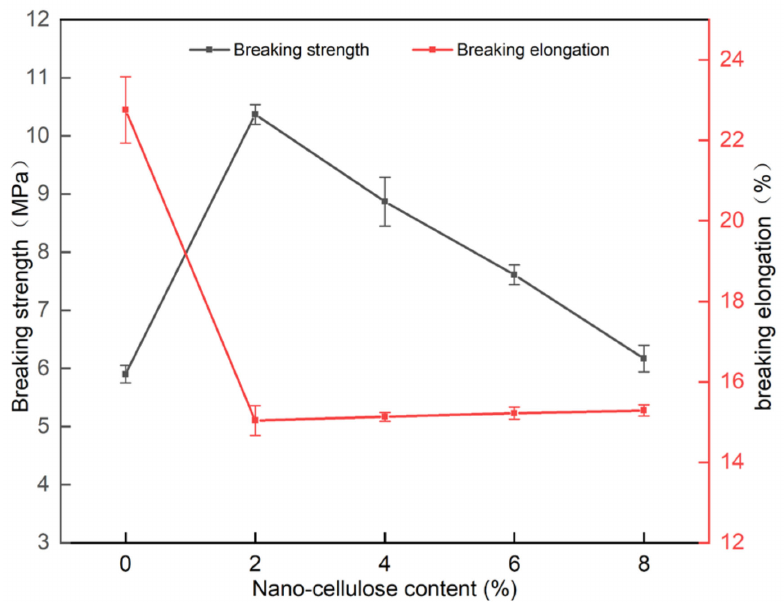
Figure 8. Breaking strength and breaking elongation of PVA/NC nanofiber membranes with different content of